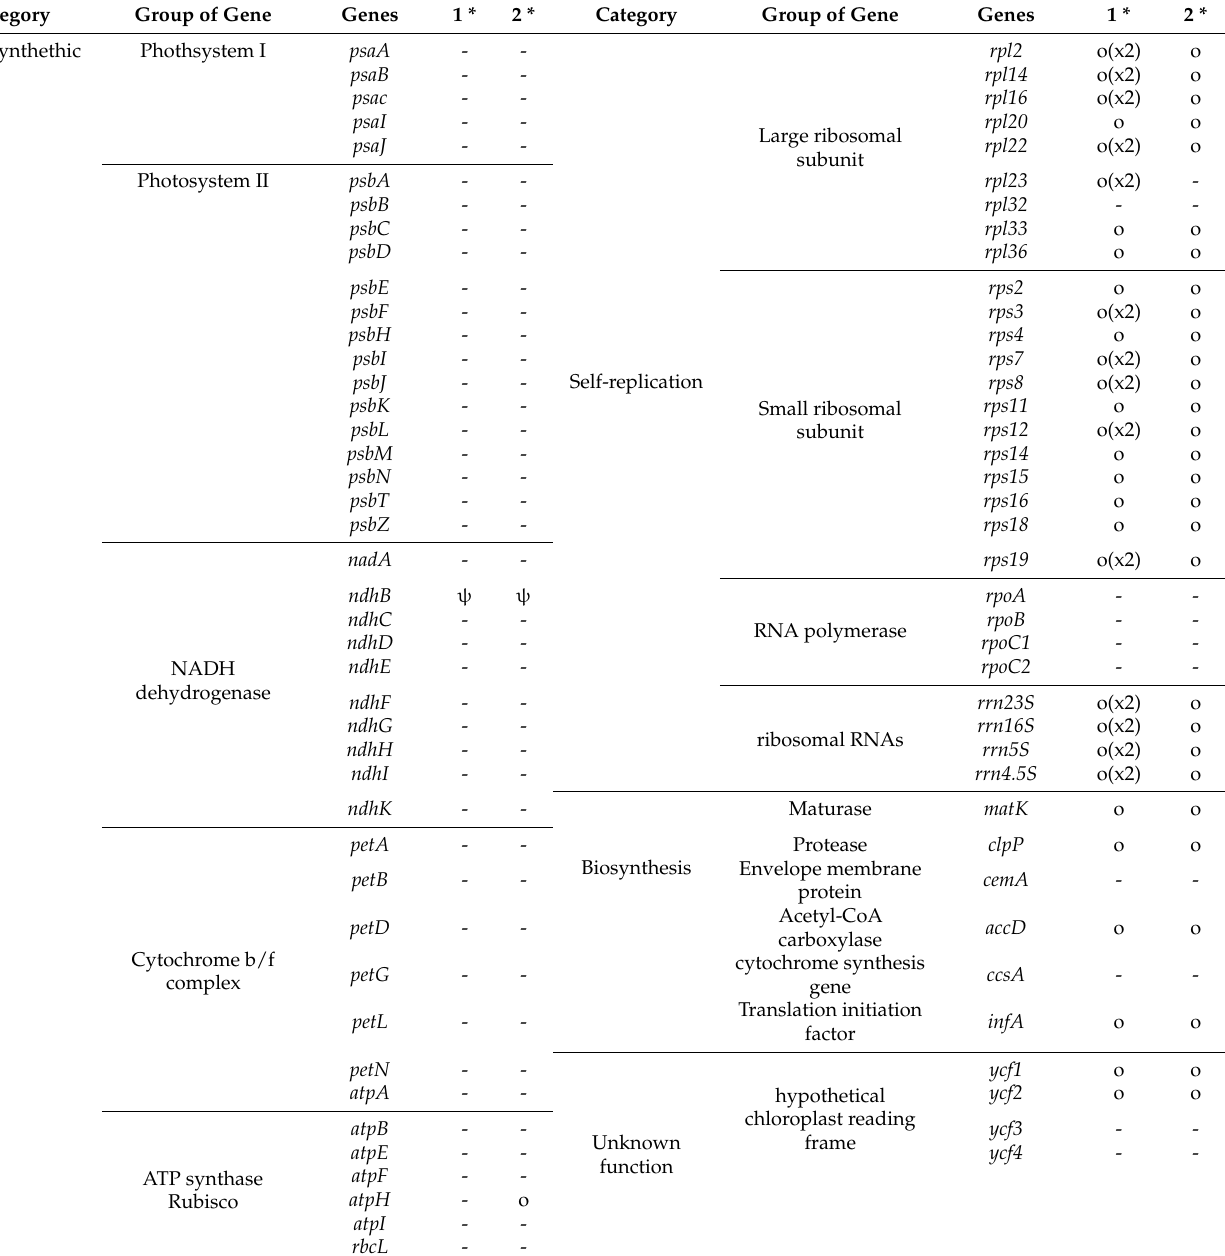
Table 1. Gene contents of A. indica as determined in the previous study [MN52962] and this study. -; absent, o: present, (x2 ): numbers of